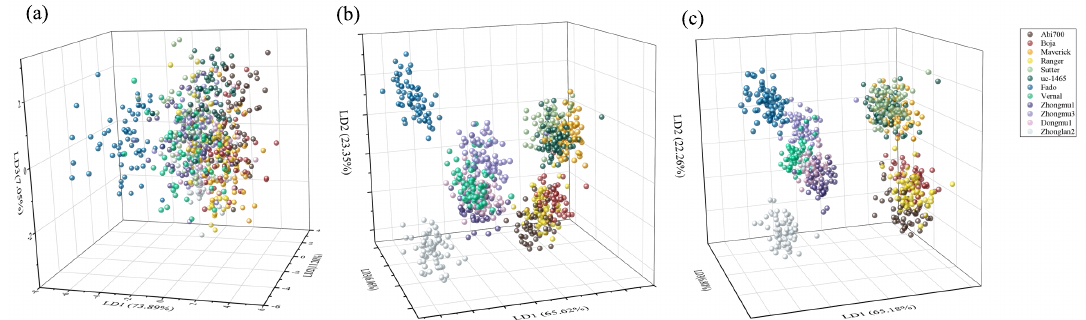
Figure 4. Score plot of linear discrimination analysis (LDA) model for discrimination twelve cultivars seeds of Medicago sativa L. based on ( a ) morphological, ( b ) spectral and ( c ) morphological combined with spectral